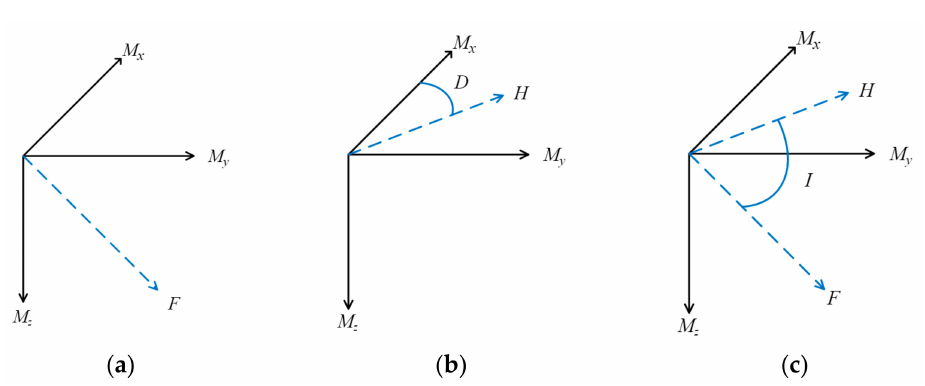
Figure 1. Geomagnetic field measurement: ( a ) geomagnetic field strength F ; ( b ) geomagnetic field declination D ; and ( c ) geomagnetic field inclination I